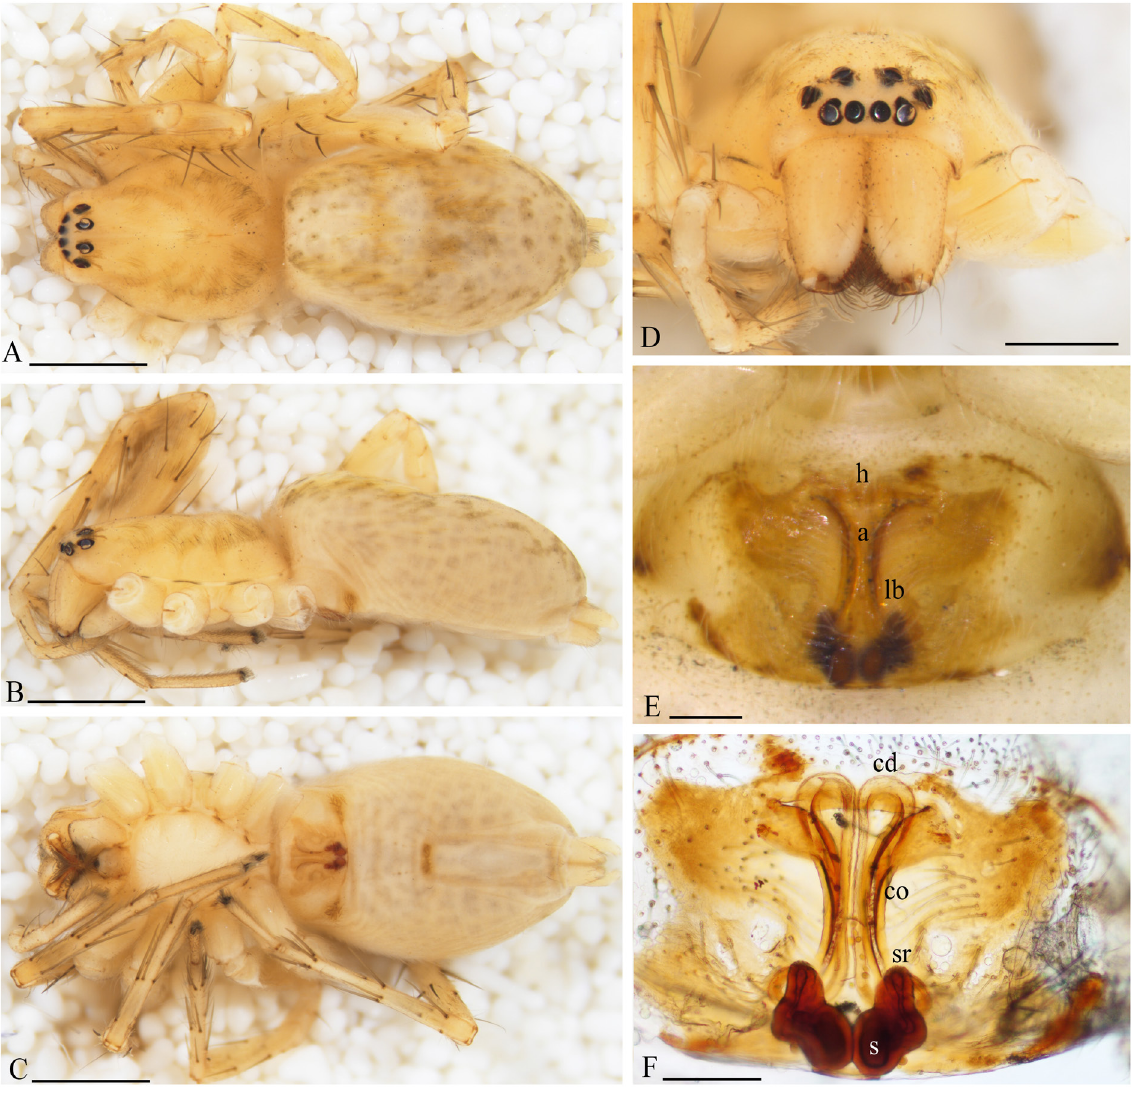
Fig. 39. Anyphaena porta sp. nov. A–C . Holotype, ♀ (CNAN-T01534). E–F . Paratype, ♀ (CNAN-T01564). A . Dorsal habitus. B . Lateral habitus. C . Ventral habitus. D . Prosoma, anterior view. E . Epigynum ventral. F . Epigynum ventral cleared. Scale bars: A–C = 1.0 mm; D = 0.5 mm; E–F = 0.2